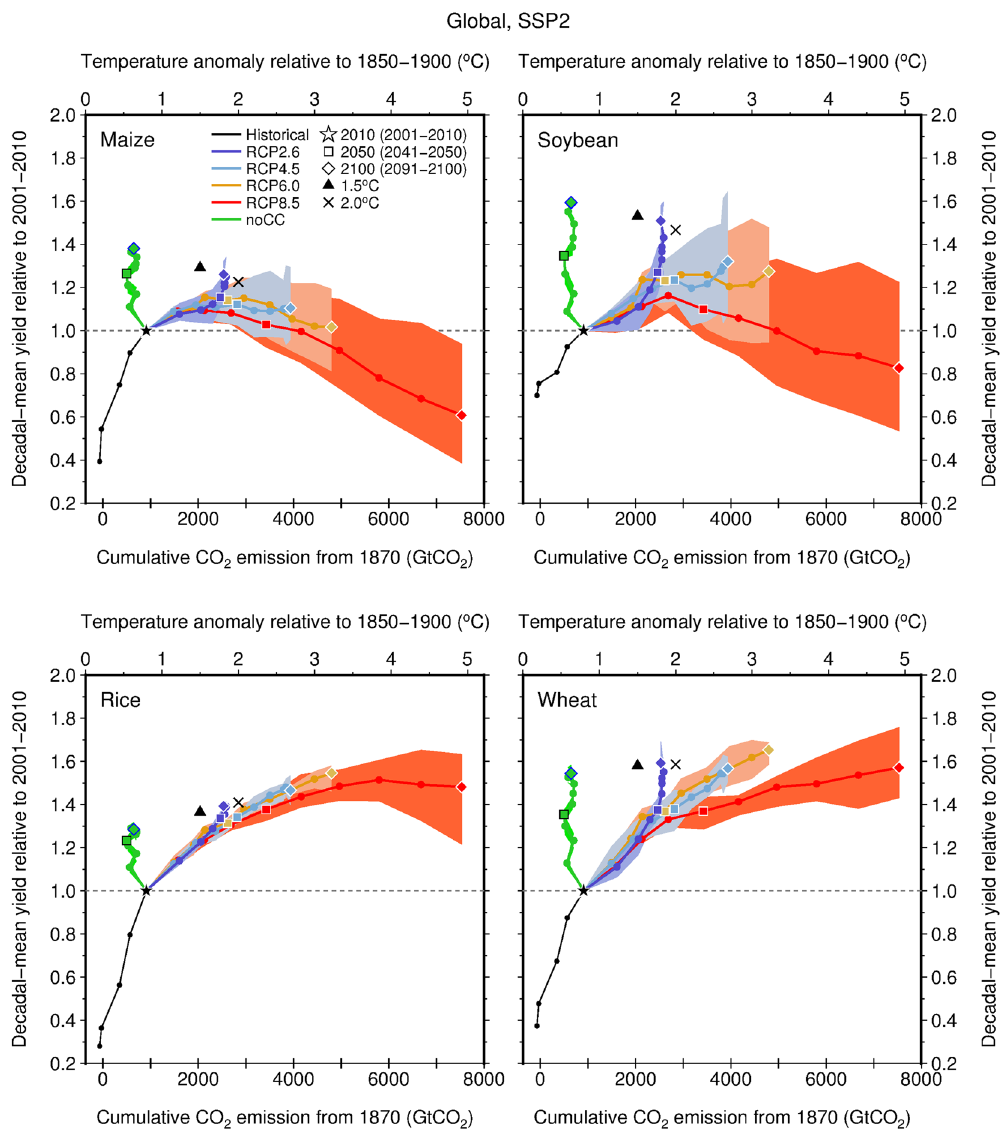
Figure 2. Responses of crop yield growth to global temperature changes and cumulative CO 2 emissions from preindustrial levels under SSP2 (intermediate technological change). Decadal global mean yields of maize, soybean, rice and wheat (y-axis) are expressed as a function of cumulative total global CO 2 emissions for 1870 (lower y-axis) or as a function of global decadal mean surface temperature anomalies relative to 1850–1900 (upper y-axis). Solid-colored lines with dots denote the ensemble mean for each RCP calculated from five GCMs. The colored-shaded area denotes the ensemble spread (from minimum to maximum) for each RCP. Data for the assumption of no climate change (noCC, five members) and SSP2 are also presented as a source of reference. Relative yields for a temperature increase of 1.5 °C were linearly interpolated from ensemble mean data derived from the noCC and RCP2.6 cases for 2100, whereas those for a temperature increase of 2 °C were based on the RCP2.6 and RCP4.5 cases for